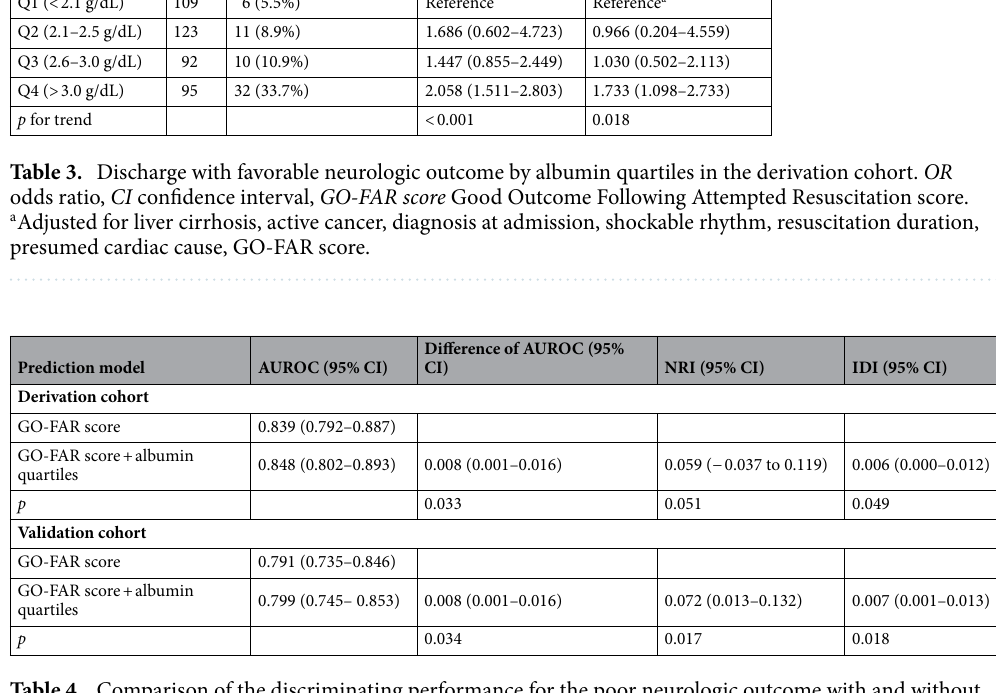
Table 4. Comparison of the discriminating performance for the poor neurologic outcome with and without the albumin quartiles by AUROC, NRI, and IDI in the derivation and validation cohorts. AUROC area under the receiver operating characteristic curve, NRI net reclassification index, IDI integrated discrimination improvement, CI confidence interval, GO-FAR score Good Outcome Following Attempted Resuscitation score.